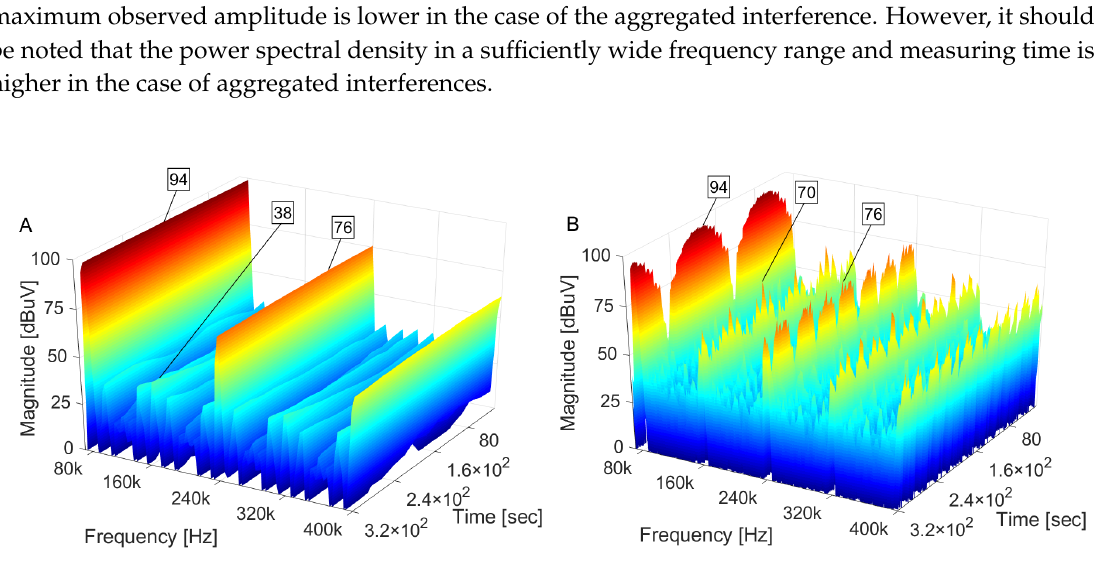
Figure 2. Simulation 3D spectrograms of interference caused by one DC/DC converter with DetM ( A ), and two DC/DC converters with DetM ( B